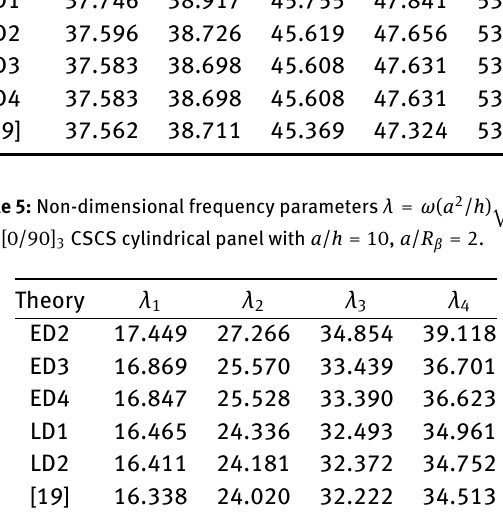
Table 5: Non-dimensional frequency parameters λ = ω ( a 2 / h )